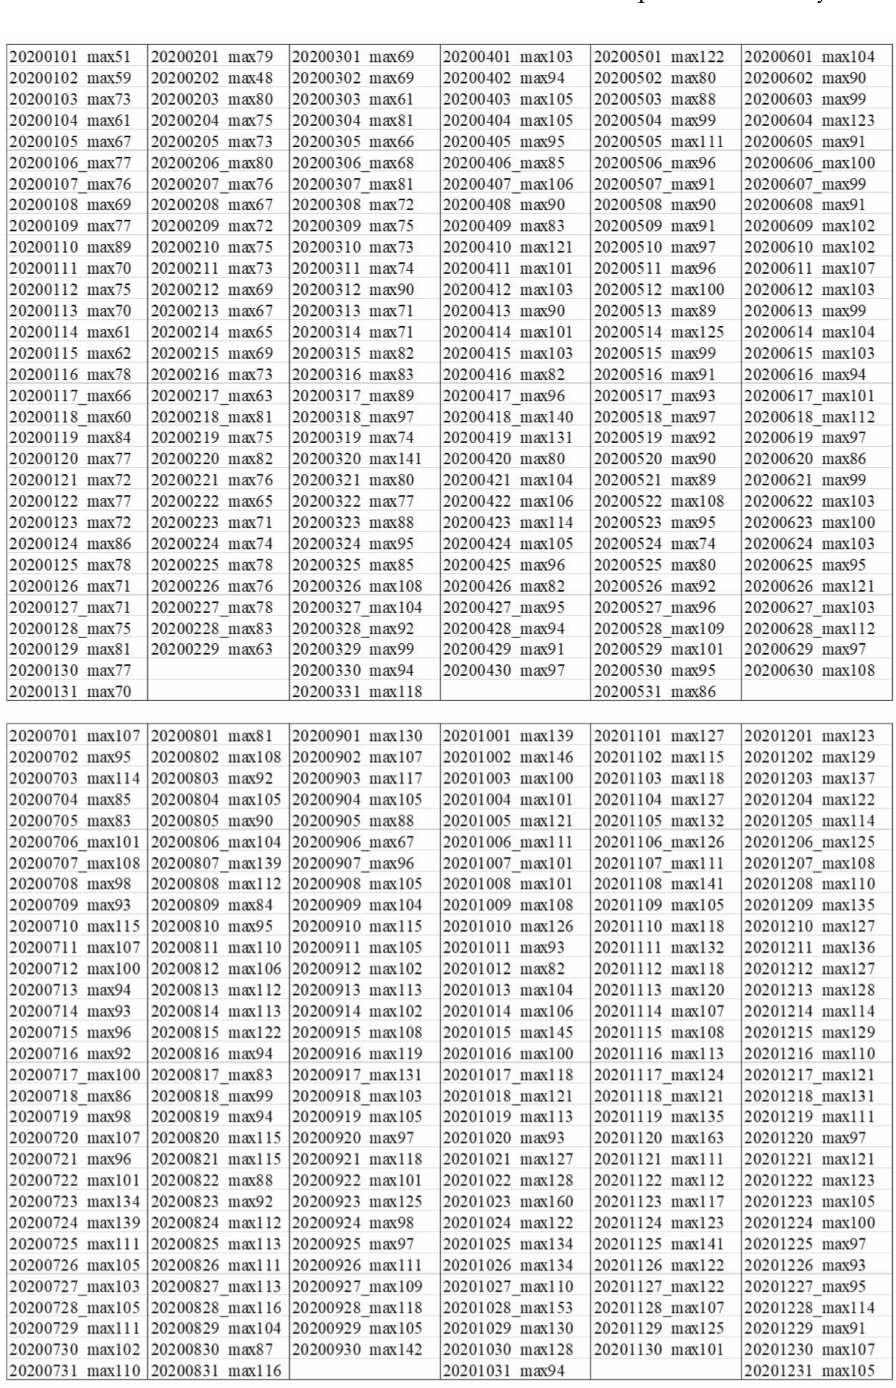
Figure 3. Daily detected event hot topics in